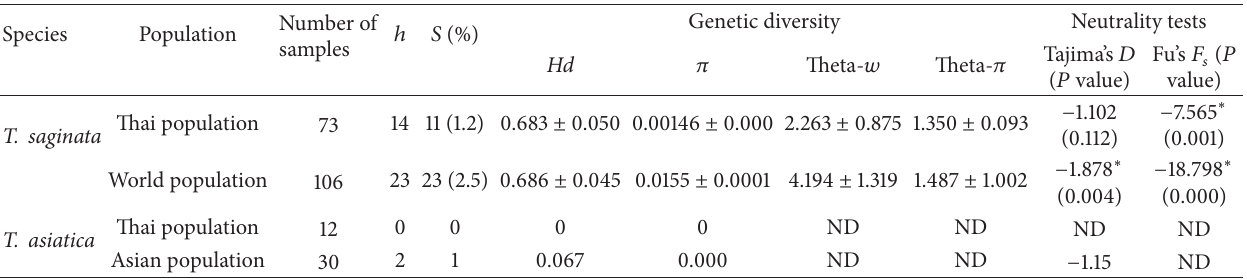
Table3:Geneticdiversityandtestof T.saginata population,73from4differentgeographicalregionsofThailand,33from11differentcountries and of T. asiatica , 12 from Kanchanaburi province, and 18 from 7 different countries.